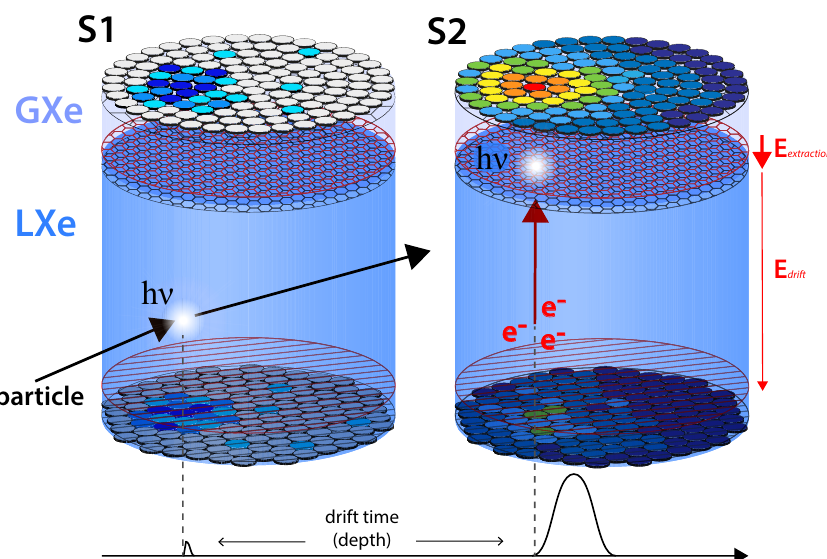
Figure 1. Schematic view of the working principle of a dual-phase TPC. The prompt scintillation signal ( S 1) is observed by both the top and bottom PMT arrays. Ionization electrons are drifted from the interaction vertex towards the LXe/GXe interface by means of a uniform electric field ( E drift ) between the cathode (bottom red) and gate (right below the liquid–gas interface, black) electrodes. The S 2 signal is formed via proportional scintillation triggered by electrons extracted in the gaseous region. The intense extraction electric field ( E extraction ) is established between the gate electrode and the anode (top red). The top (bottom) screening electrode is also shown in black, right below (above) the PMT array. The localized pattern of the S2 signal in the top PMT array is used to reconstruct the interaction position in the ( x , y ) plane. The time delay between S 1 and S 2 informs about the z -coordinate. The energy is reconstructed from the combination of both S 1 and S 2